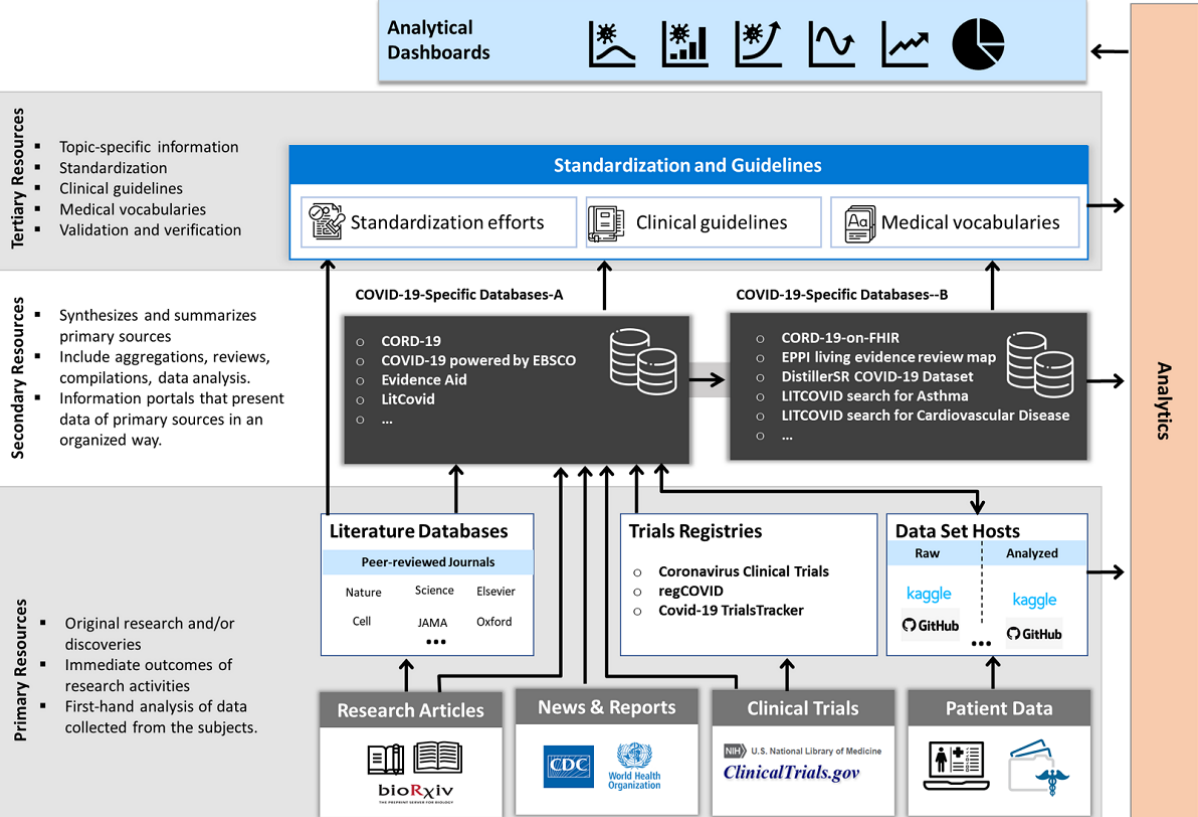
Figure 9. An enterprise architecture framework for COVID-19–related efforts and initiatives involving primary, secondary, and tertiary knowledge resources. CORD-19: COVID-19 Open Research Dataset, FHIR: Fast Healthcare Interoperability Resources, EPPI: Evidence for Policy and Practice Information and Co-ordinating Centre, JAMA: Journal of the American Medical